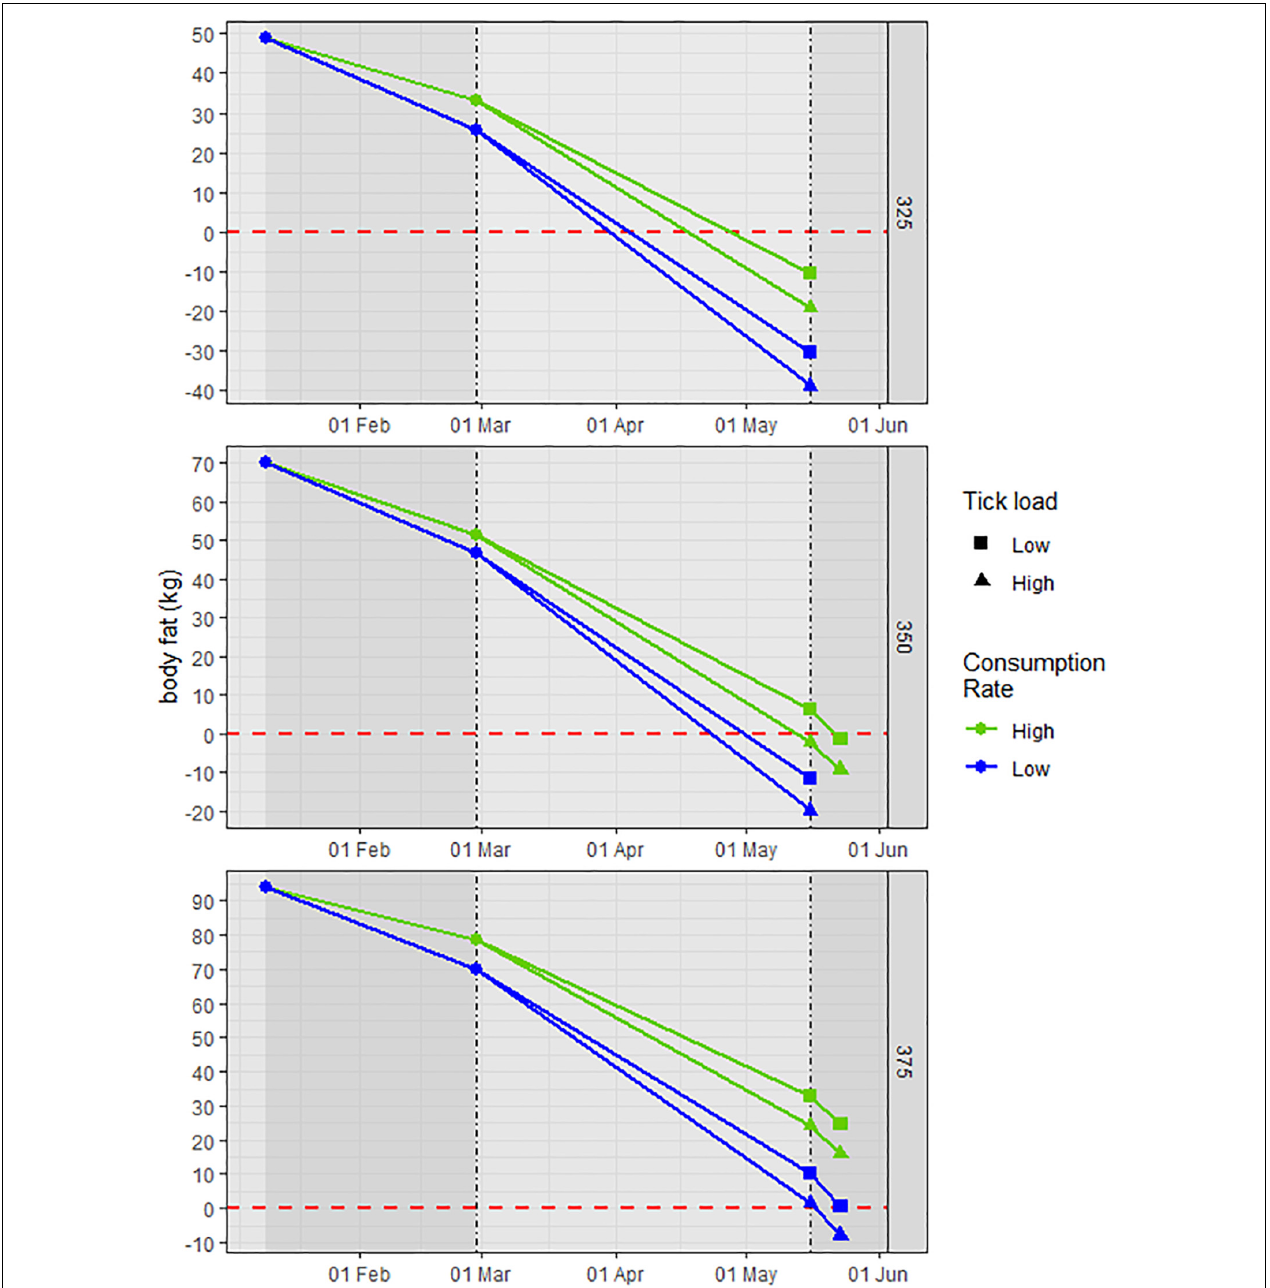
FIGURE 1 | An illustration of the temporal loss of endogenous body fat (BF; kg) in adult cow moose of different starting body mass (325, 350, and 375 kg) and% BF (15, 20, and 25%) from 10 January through 16 May, a period encompassing part of the 2nd trimester and the 3rd trimester of gestation, and 1 week of lactation. The inflection points on 01 March and 16 May denote the 77-day period (01 March–16 May) of the 3rd trimester and 1 week of lactation (17–23 May). Consumption rate was varied as 1 and 1.2% body mass, and infestation was based on 90,000 ticks at two ratios of adult females – 25 and 50%. An energy balance equation was used to calculate the BF (kg) required to meet the energy deficit from the difference between the total daily energy cost (field metabolic rate, gestation, blood loss to ticks, and lactation) and consumption (kJ/d); the BF value on any given day represents the remaining endogenous BF